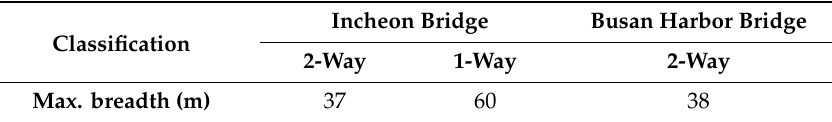
Table 12. Maximum breadth of bridge crossing waterway.